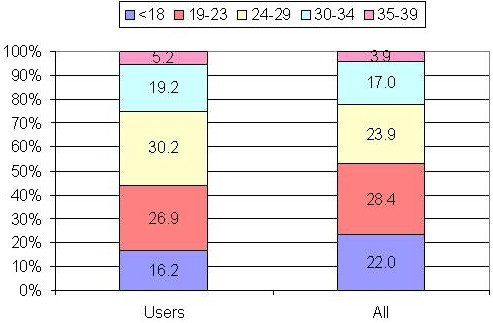
Age distribution in the sample (n = 874) and user sub-sample (n = 520).